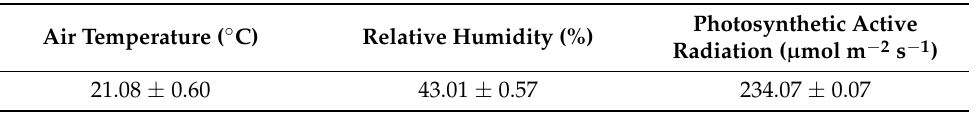
Table 1. Air temperature, relative humidity and photosynthetic active radiation measurements inside the tunnel during the growing season of the study (July–December